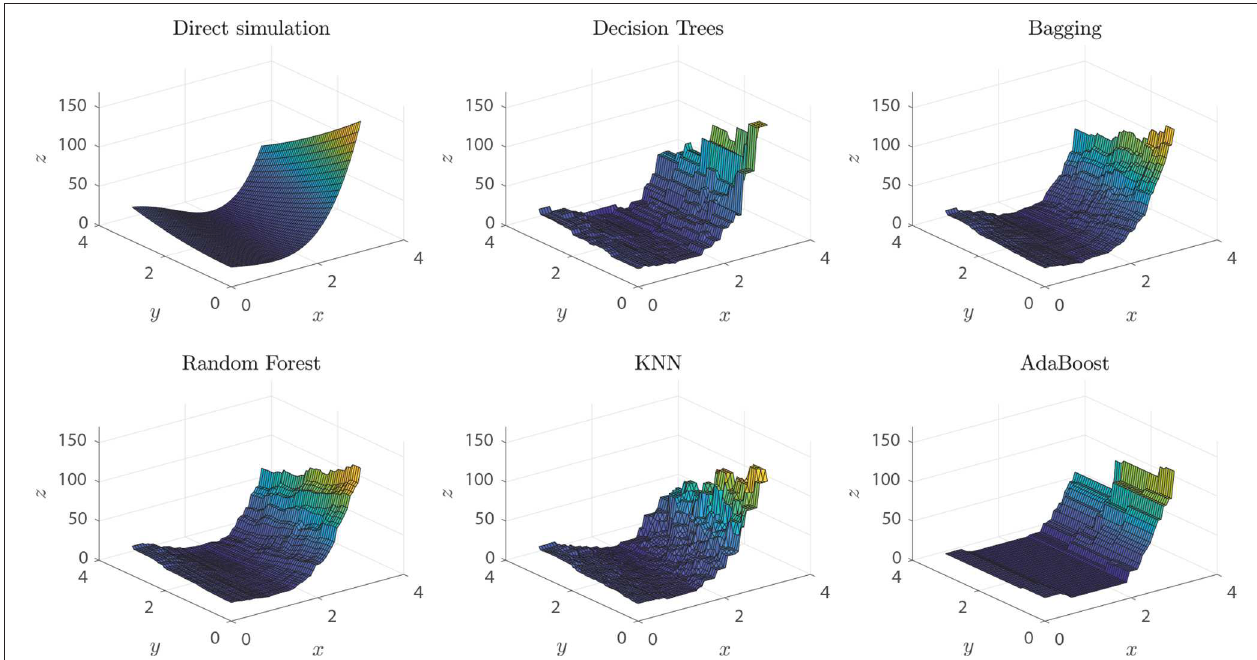
FIGURE 11 | Rosenbrock function predictions of each of the different models generated. Direct simulation represents the real ground truth Rosenbrock function.